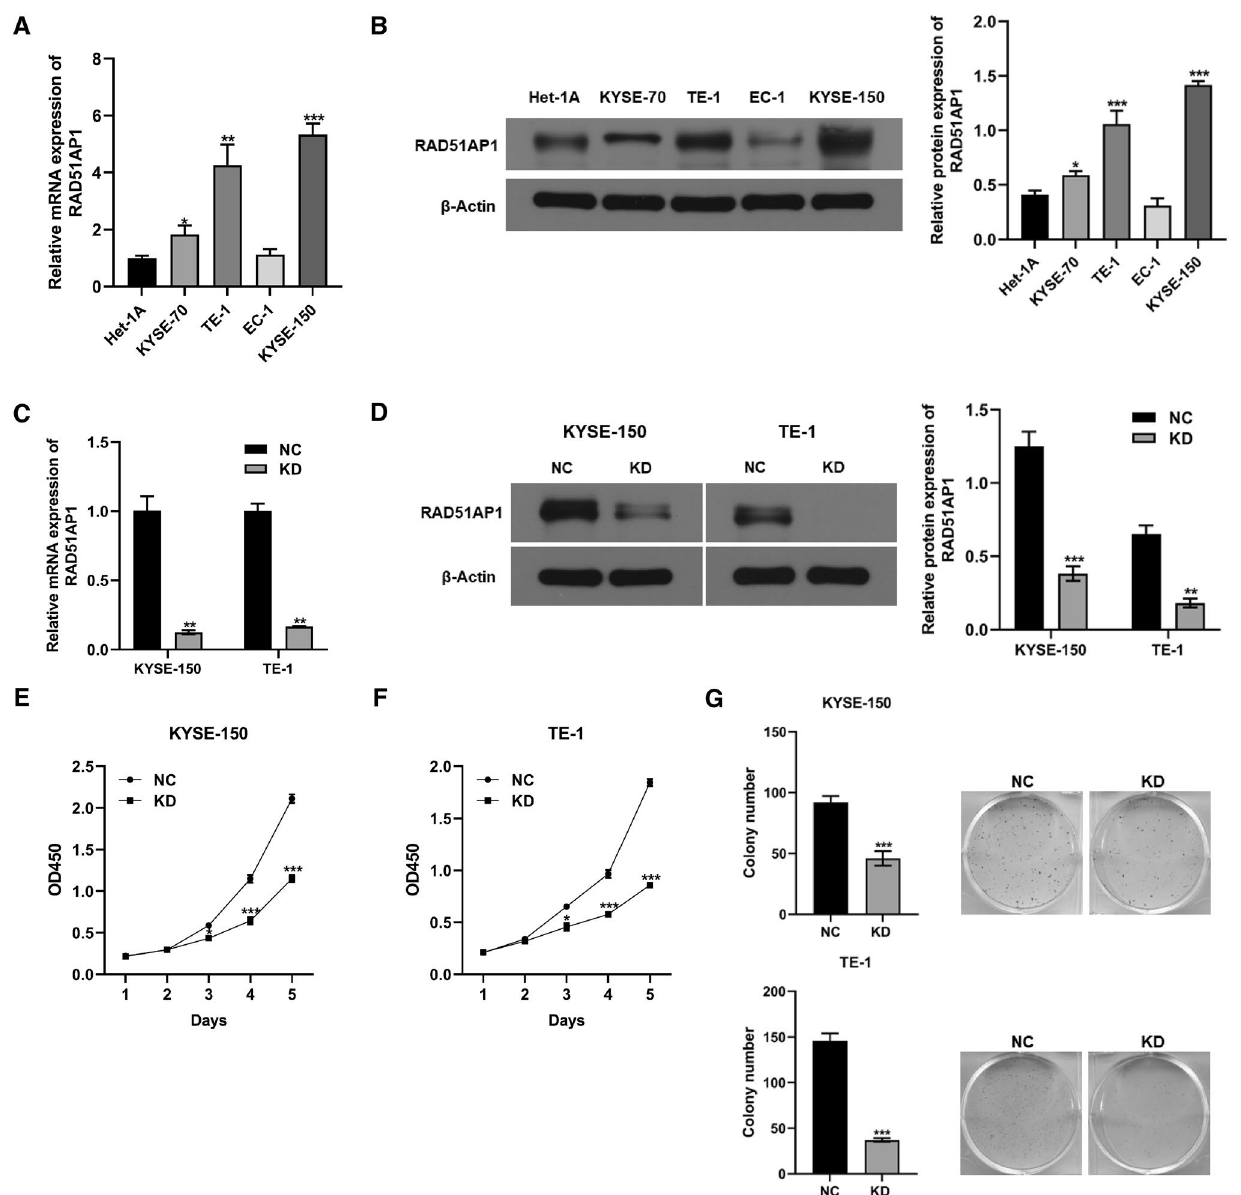
Fig. 4 Knockdown of RAD51AP1 inhibited cell proliferation in ESCC. A , B QPCR and western blot analyses of RAD51AP1 mRNA and protein expression in ESCC cell lines (KYSE70, KYSE150, TE-1, and EC-1) and esophageal epithelial cell line (Het-1A). C , D QPCR and western blot anal- yses of KYSE150 and TE-1 cells transfected with RAD51AP1 shRNA and negative control. E , F CCK-8 assay showed knockdown of RAD51AP1 significantly inhibited cell proliferation in KYSE150 and TE1 cells. G Colony formation assay showed knockdown of RAD51AP1 significantly decreased colony number of KYSE150 and TE1 cells. ESCC, esophageal squamous cell carcinoma. * p < 0.05; ** p < 0.01, *** p <